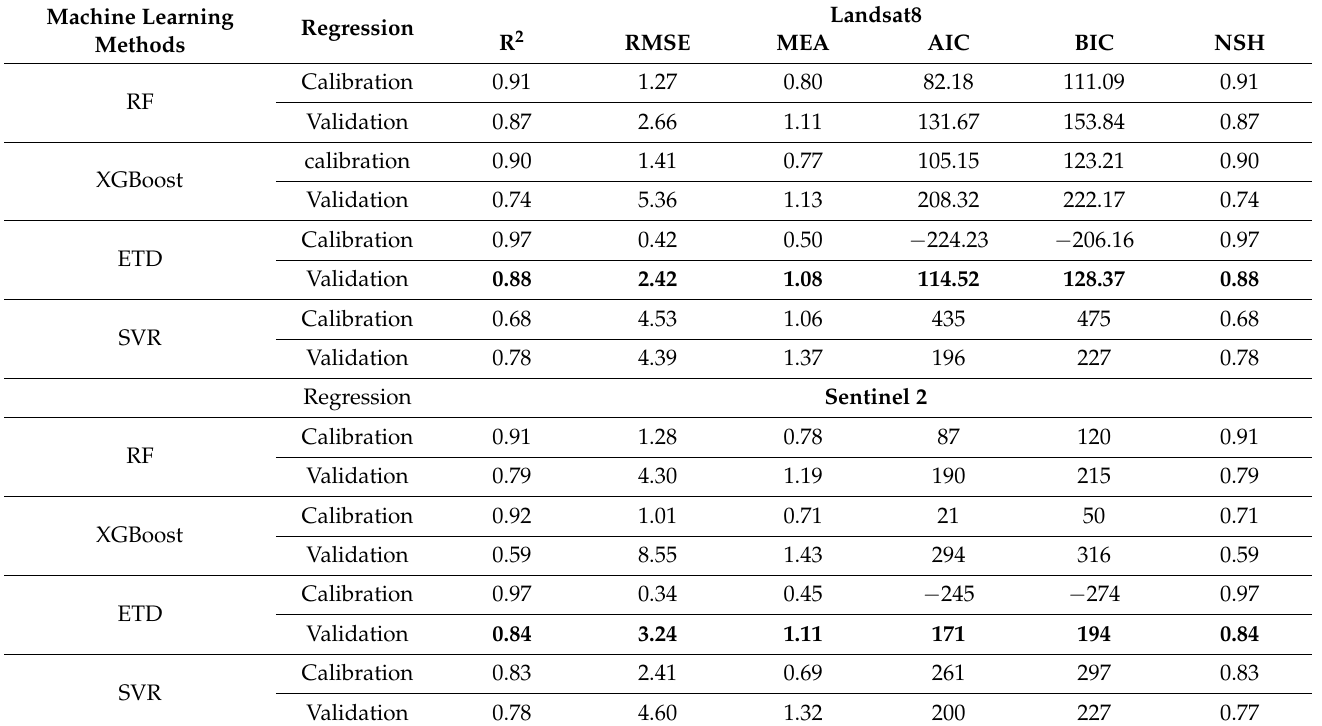
Table 9. Four machine learning methods (RF, XGBoost, extra tree decision, and SVM) used for segmentation to predict SMC. Best validation results are